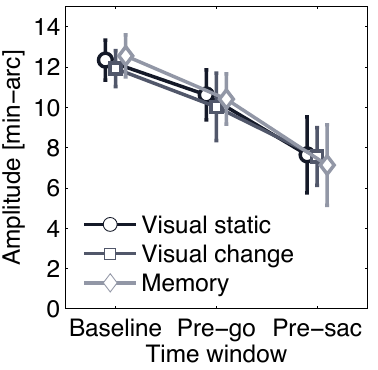
Figure 4 . Mean microsaccade amplitude in three time win- dows: Baseline (last 100 ms before target onset), Pre-go (last 100 ms before go signal), and Pre-sac (last 100 ms before the response saccade) is plotted for each condition separately. Er- ror bars are 95% confidence intervals.